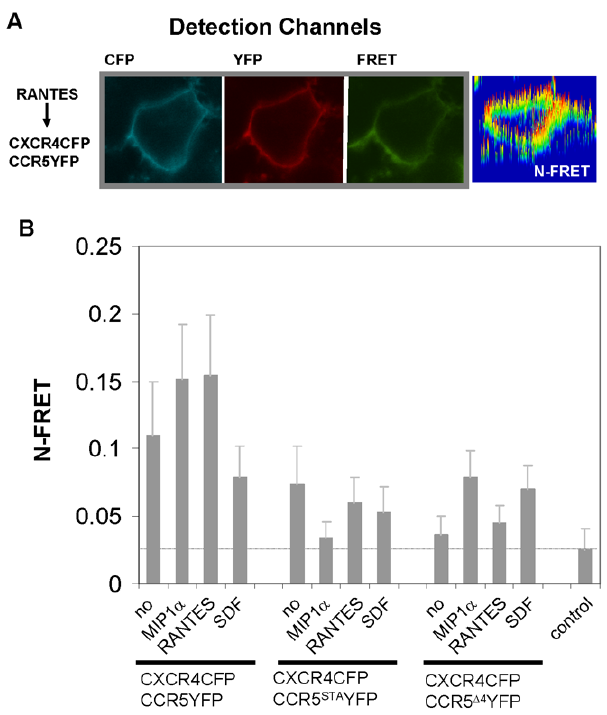
Figure 5. Ligand-binding induced FRET changes between heterodimers. A. A representative image of a cell expressing CXCR4CFP and CCR5YFP that was stimulated with RANTES. The N-FRET image shows marked FRET signals. B. Cells expressing CXCR4CFP and CCR5YFP, or CCR5 STA YFP or CCR5 D 4 YFP were stimulated with ligands such as CCL3/MIP1 a , CCL5/RANTES, or CXCL12/SDF-1. Quantitative analyses of N-FRET under each condition. Data for N-FRET are shown as means 6 S.D. Statistically significant N-FRET changes are indicated as p- values in the results.